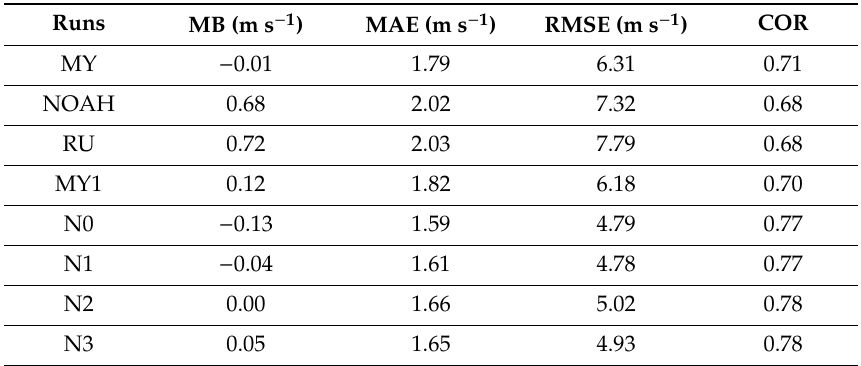
Table 7. Summary of the statistics between predicted and measured 10 m wind speed at meteorological stations in the Mediterranean